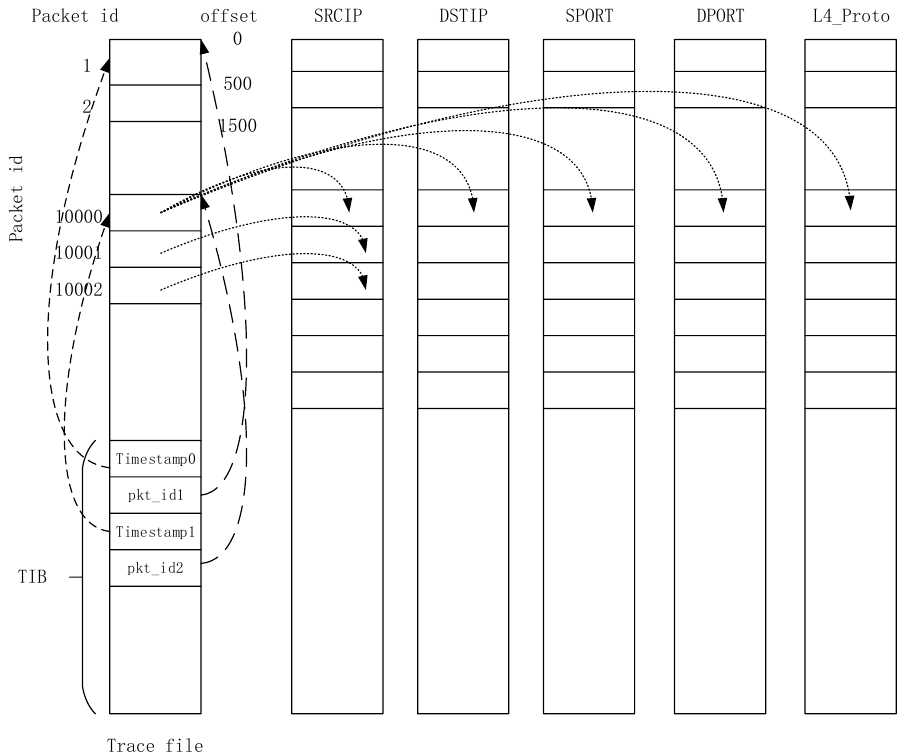
Figure 6. Extracting index data from a packet trace file.